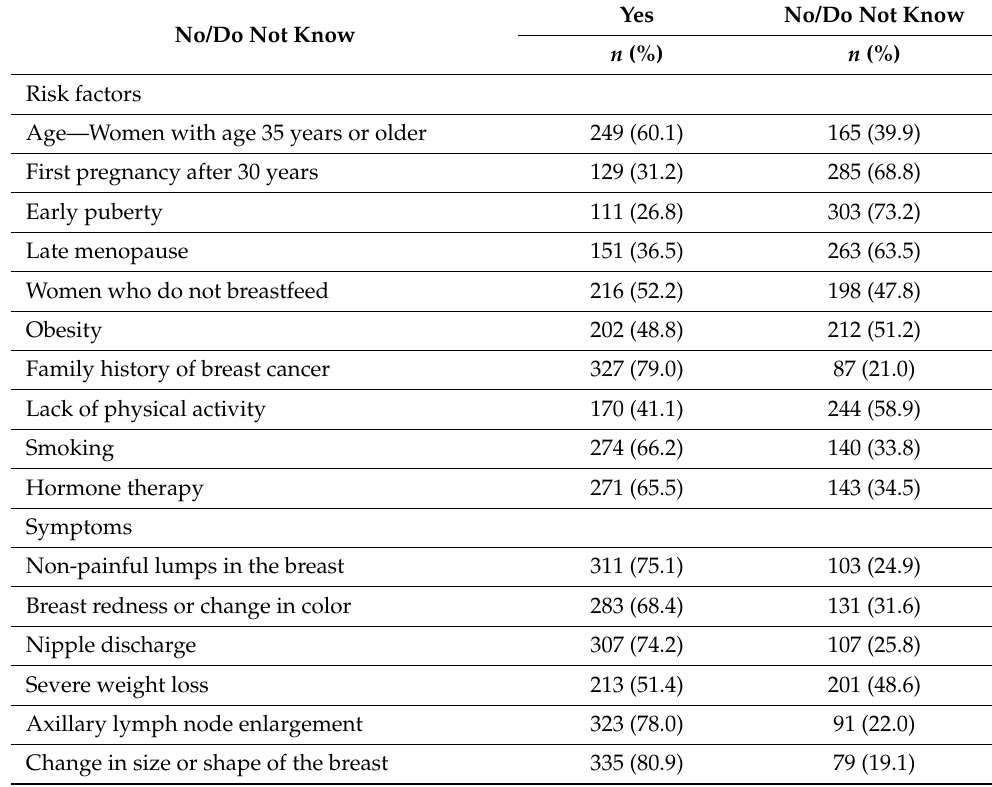
Table 2. Participants knowledge regarding breast cancer risk factors and symptoms ( n = 414).